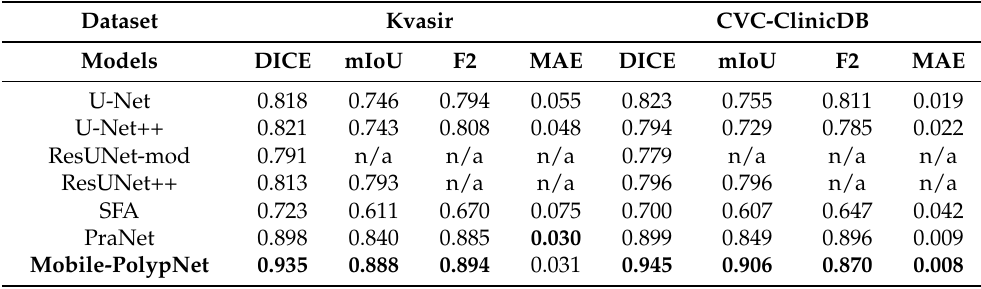
Table 1. Model’s performance and comparison with other models on the test dataset. Results have been reported from the PraNet [4] paper and have not been verified. The bold is to identify the best of the